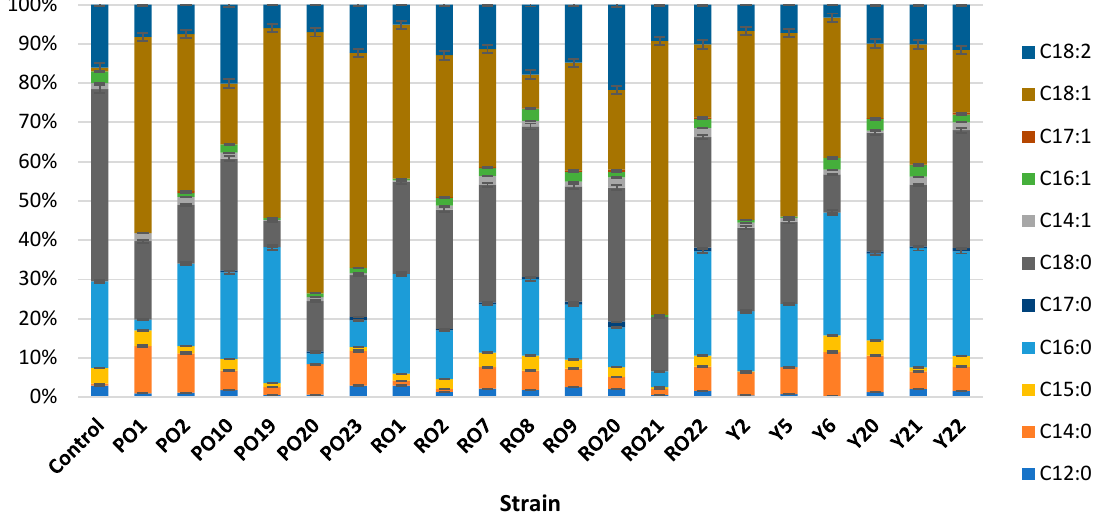
Figure 3. Relative abundance of FFAs released by different Y. lipolytica strains inoculated in butter samples. The values are the mean of three replicates and are expressed in percentage (%) with respect to the total area measured.